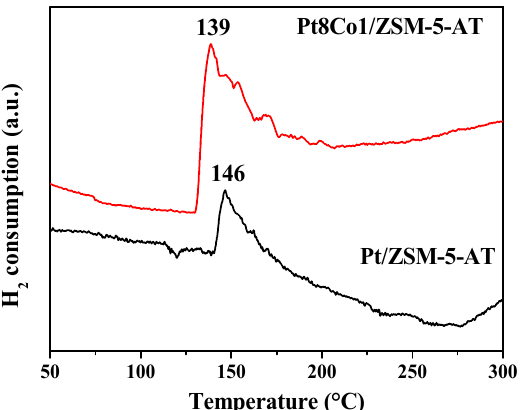
Figure 6. The H 2 -TPR profiles of the as-prepared Pt8Co1/ZSM-5-AT and Pt/ZSM-5-AT catalysts.